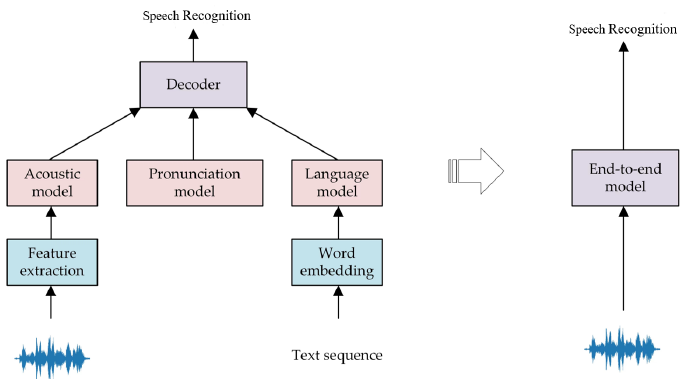
Figure 2. Comparison between traditional and E2E speech